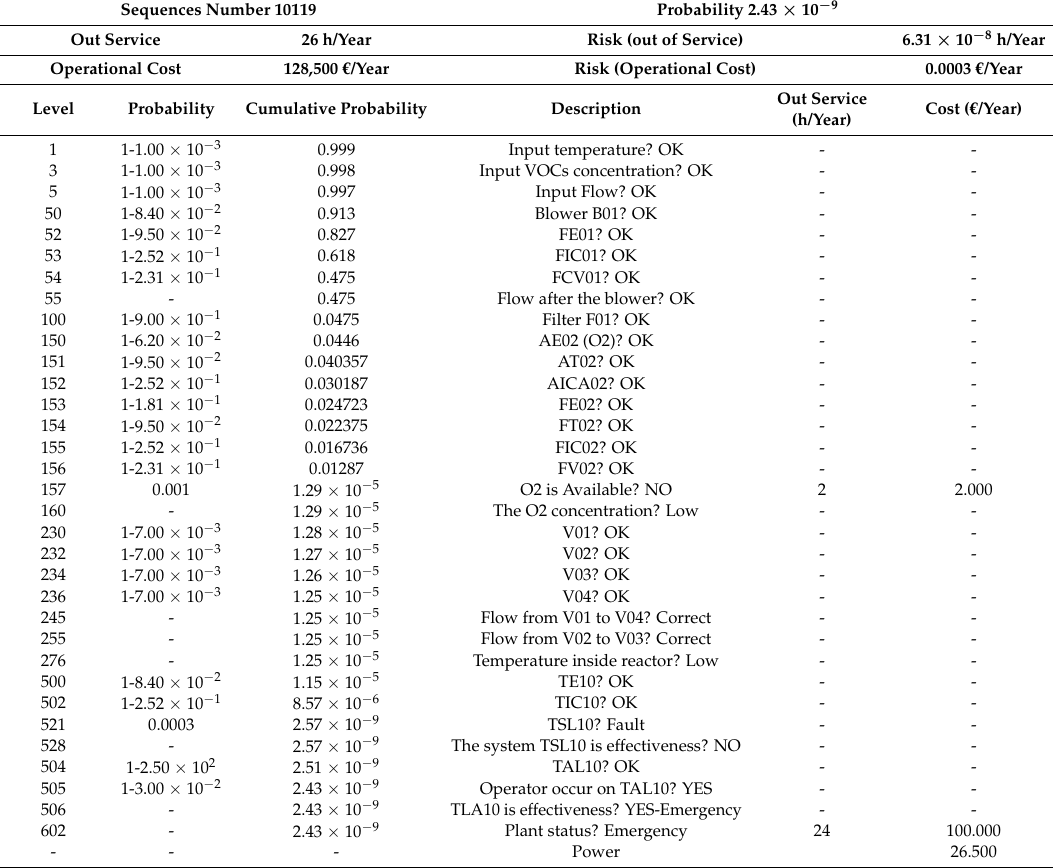
Table 3. Example of an events’